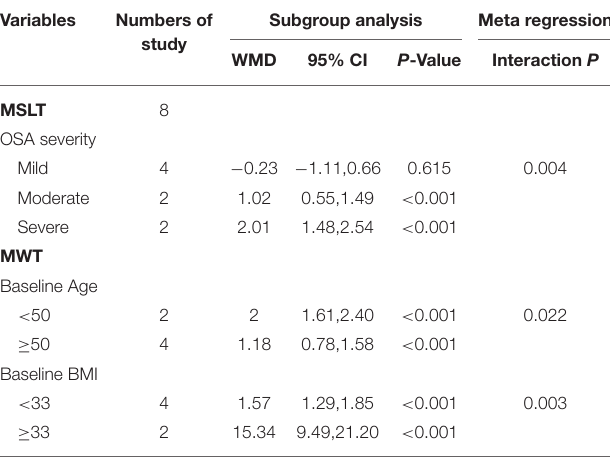
TABLE 3 | Meta-regression and subgroup analysis for obejective excessive daytime sleepiness (EDS) based on Basic characteristics of patients and studies in different severity of